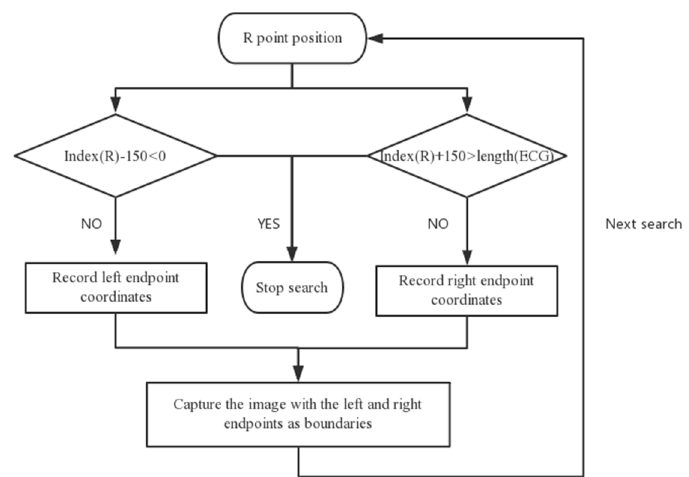
Figure 6. ECG beat extraction process.